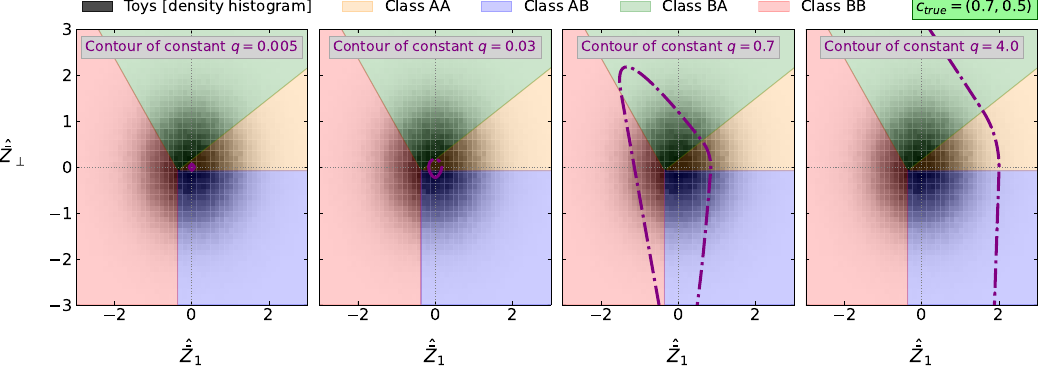
ˆ¯ Z ˆ¯ Z ) -contours which lead to four different values of q ≡ q Figure 15: ( , ⊥ 1 shows the integrands when we integrate the density along each contour.